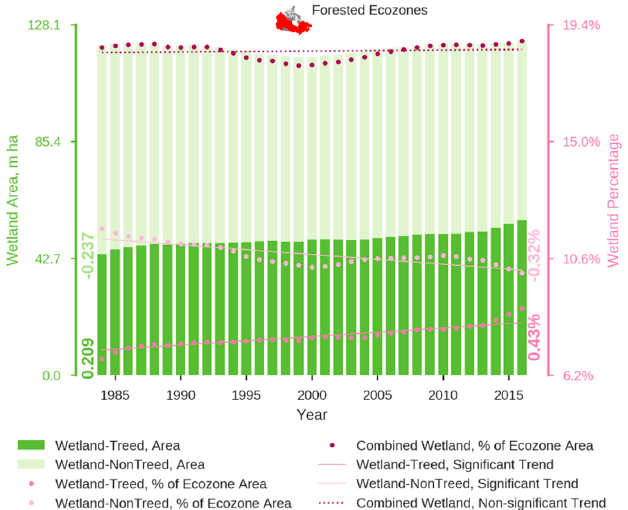
Figure 2. Wetland area (bars, left axis), the wetland percentage (dots, right axis) of the whole forest-dominated ecozones of Canada, and their trends (lines). Increasing/decreasing rates in wetland coverage (numbers beside trend lines at the two sides of the graph, with the left being area per year and the right being percentage per year) are given for statistically significant trends in treed and non-treed wetlands, as determined by the Theil-Sen slope estimator. Table 2. Temporal trends in wetland extent identified from the Theil-Sen slope estimator and Mann-Kendall test.